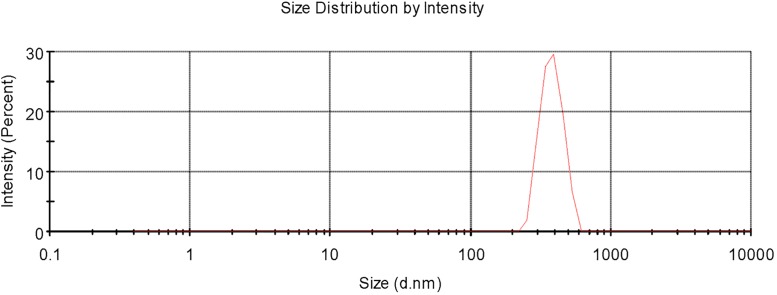
Particle size distribution of sex pheromone-loaded MPEG5000-PCL2000 nanoparticles.